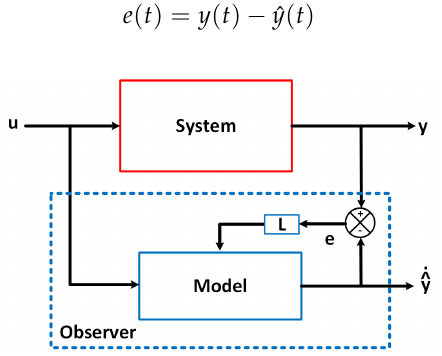
Figure 11. State observer general